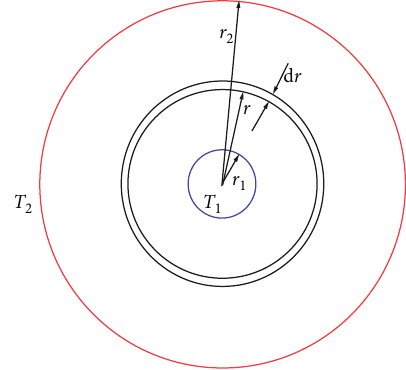
Figure 10: Heat conduction of frozen